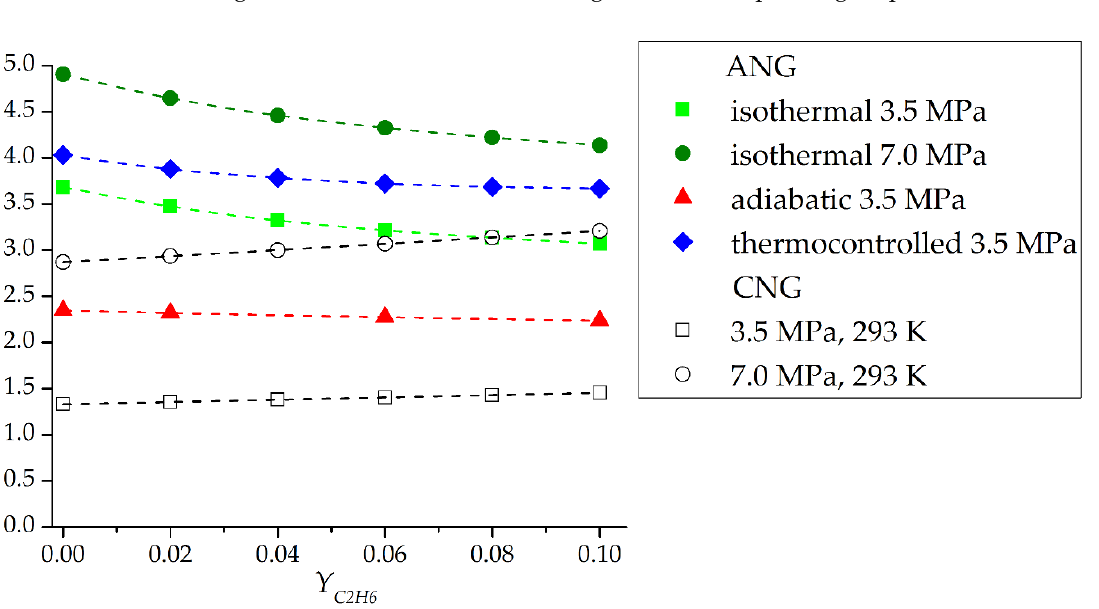
Figure 16. Dependence of the active energy capacity of the gas leaving the storage with a volume of 1 m 3 for 1 cycle based on ACPK adsorbent based on the results of modeling cyclic processes. ANG is the adsorption gas storage. CNG is the conventional gas storage in the “isothermal” mode, without taking into account non-equilibrium intake/exhaust processes.